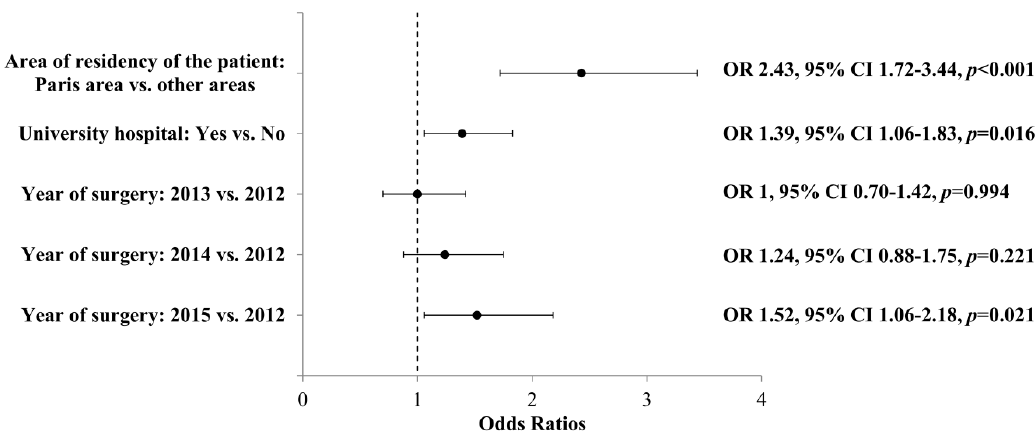
Figure 4. Multivariate analysis of factors having an influence on optimal care pathway compliance among patients operated for thyroid nodule between 2012 and 2015. FNAC: Fine-Needle Aspiration Cytology; ENDO: endocrinology consultation.